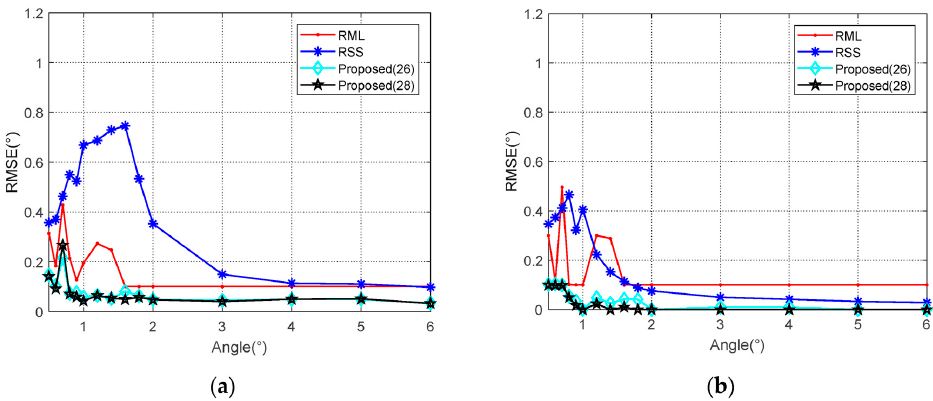
Figure10. RMSEagainstelevationangle θ indi ff erentSNRwhen ρ = 0.7. ( a )SNR = 0dB;( b )SNR = 10dB.